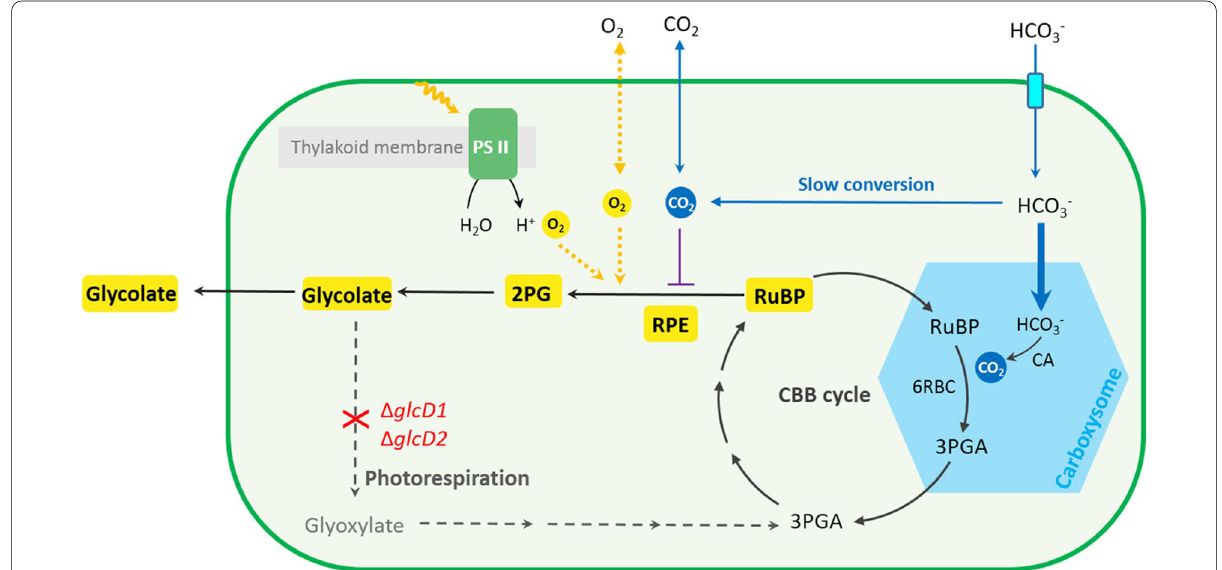
Fig. 1 Diagram of glycolate production via oxygenation function of Form II Rubisco in Synechocystis sp. PCC 6803. HCO 3 − is actively pumped (light blue) into the cytosol. While some of HCO 3 − spontaneously converts to CO 2 in cytosol, most of HCO 3 − enters the carboxysome (blue hexagon) and is converted to CO 2 by the sequestered carbonic anhydrase (CA). RuBP enters the carboxysome and the sequestered Rubisco of Synechocystis (6RBC Rubisco) combines RuBP with CO 2 to generated two molecules of 3-phophoglycerate (3PGA). 3PGA escapes to the cytosol and RuBP is regenerated through the Calvin-Benson-Bassham (CBB) cycle. Photorespiration (gray dashed arrows) can be blocked by inactivating (red cross) two glycolate dehydrogenases (GlcDs) encoded by glcD1 and glcD2 , respectively. The resulting strain WT-ΔglcD accumulates and excretes glycolate to the culture (yellow). Form II Rubisco from the endosymbiont of Riftia pachyptila (RPE Rubisco) was overexpressed in strain WT-ΔglcD and located in the cytosol. As cyanobacteria performs oxygenic photosynthesis, RPE Rubisco catalyzes the oxygenation of RuBP to 2-photoglycolate (2PG), facilitating glycolate production. As CO 2 can freely diffuse to the cytosol (blue solid arrow), the elevated CO 2 level inhibits the oxygenase function of RPE (purple solid line) and decreases glycolate production when the external inorganic carbon is supplied with CO